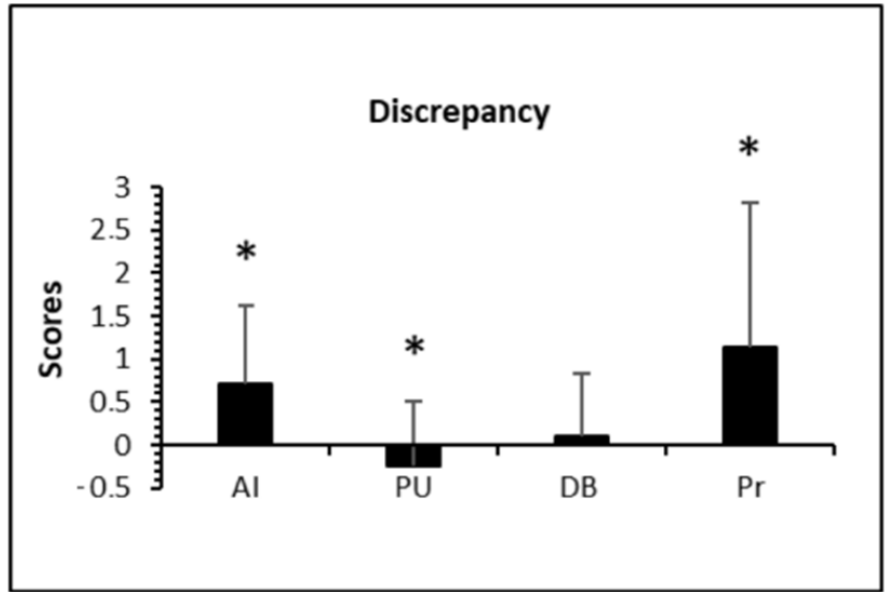
Figure 1. Discrepancies between ratings of perceived and desired behavior. Discrepancy = Perceived − Desired Behavior. Range of possible discrepancies goes from − 4 to +4. Satisfaction value = 0. AI, active involvement; PU, praise and understanding; DB, directive behavior; Pr, pressure. * Significant discrepancy ( p <